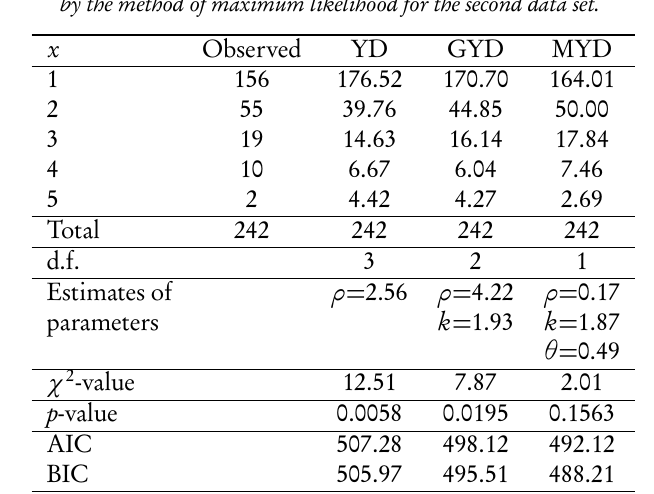
Observed frequencies and computed values of expected frequencies of the MYD, the GYD and the YD by the method of maximum likelihood for the second data